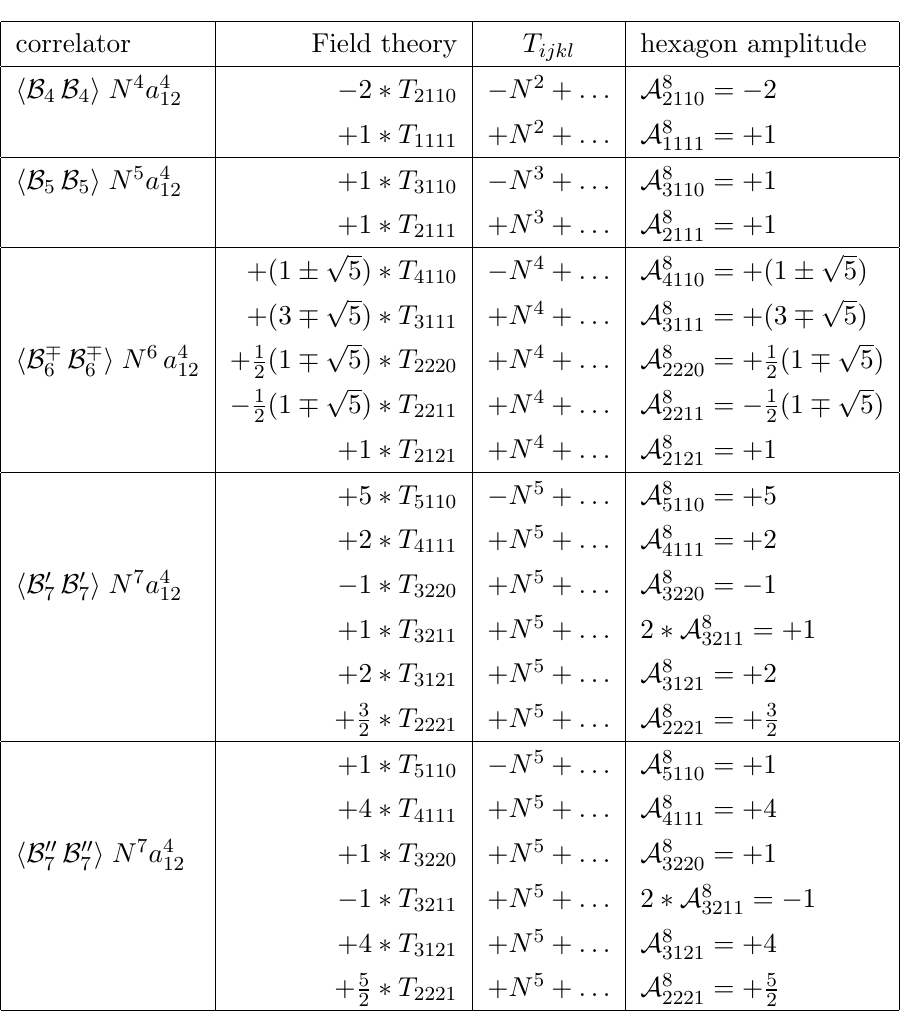
Table 5 . The torus part of two-point functions of single-trace operators with SU( N ) gauge group. For the two-point functions in the (cid:12)rst column, we (cid:12)rst list the result of Wick contractions